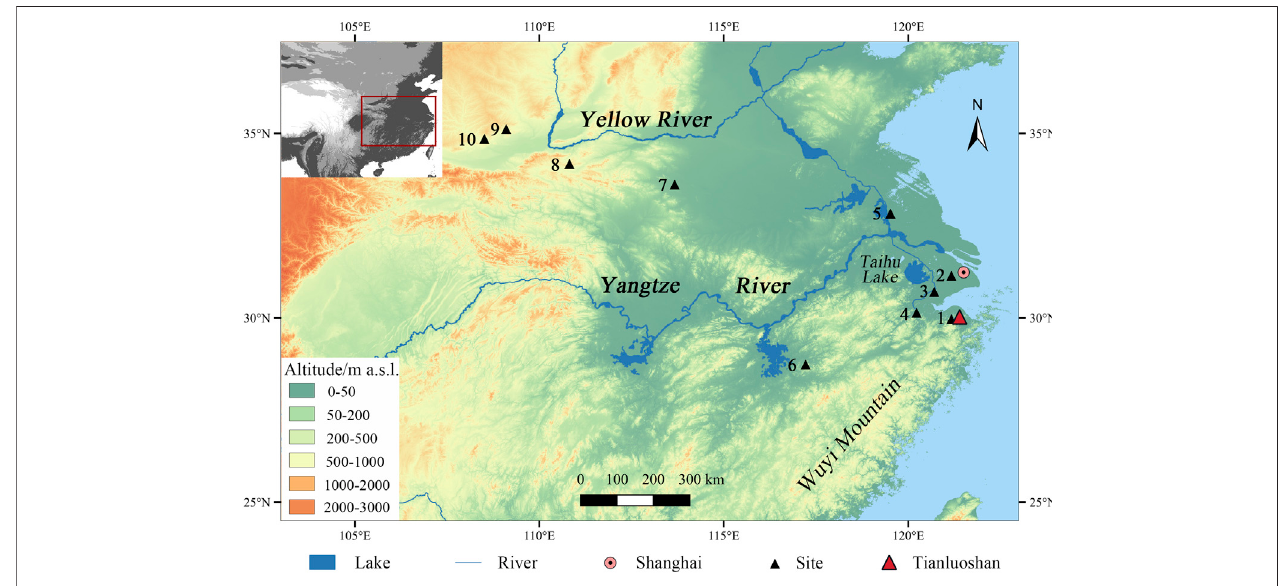
FIGURE 1 | Site location of Tianluoshan and sites with sika deer